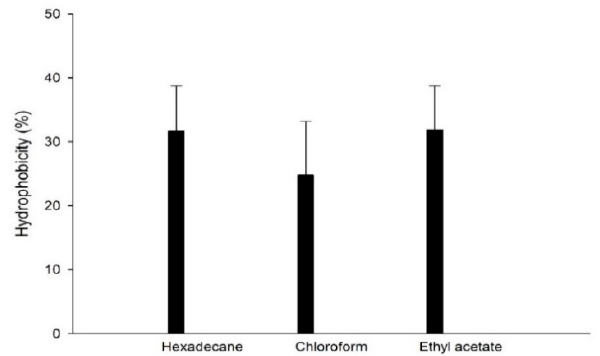
Figure 1. Cell hydrophobicity of MKHJ 1-1 against various solvents.